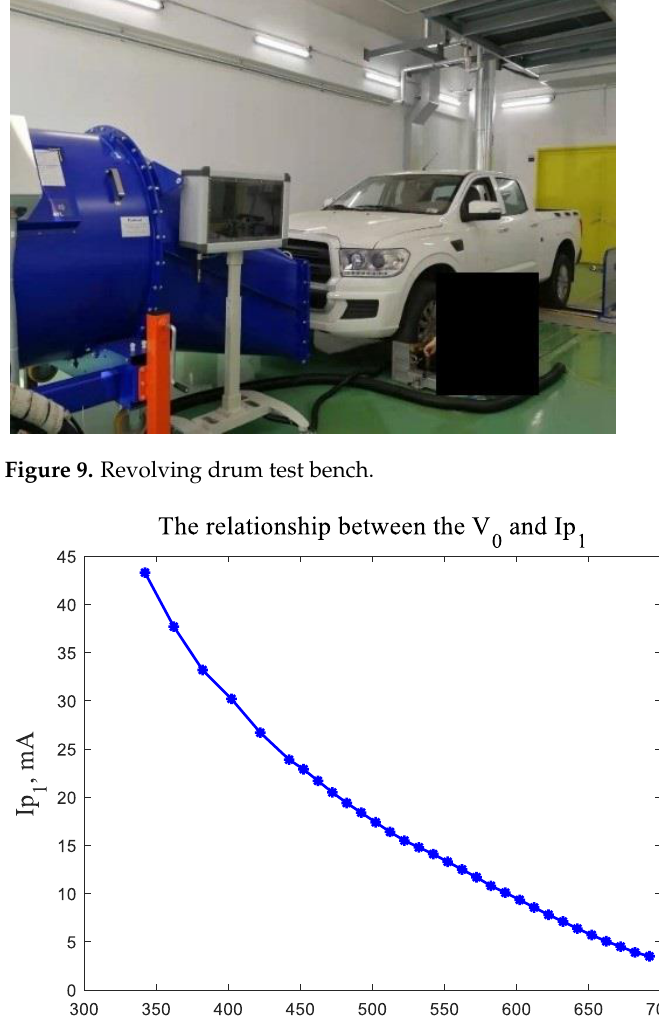
Figure 8. Diesel pickup truck.